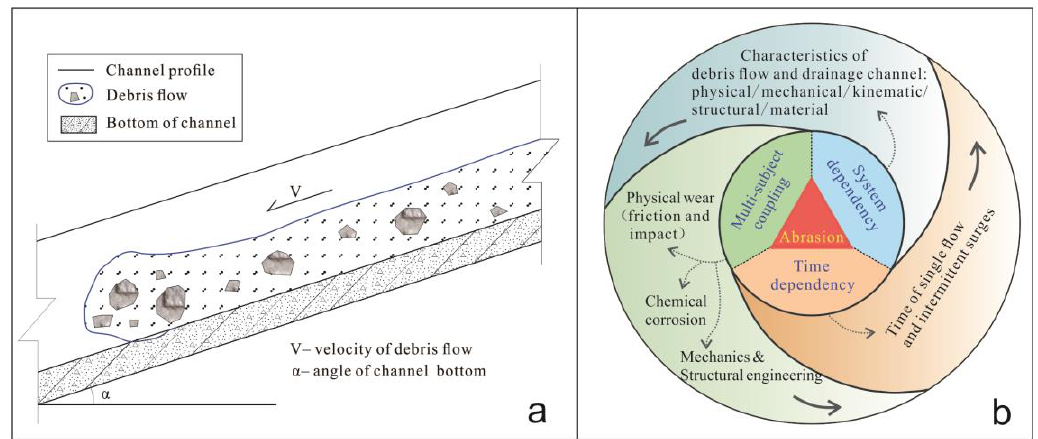
Figure 4. Schematic diagram of abrasion system of DCLG. ( a ) Profile of debris flow in the drainage channel; ( b ) elements of abrasion system of DCLG.